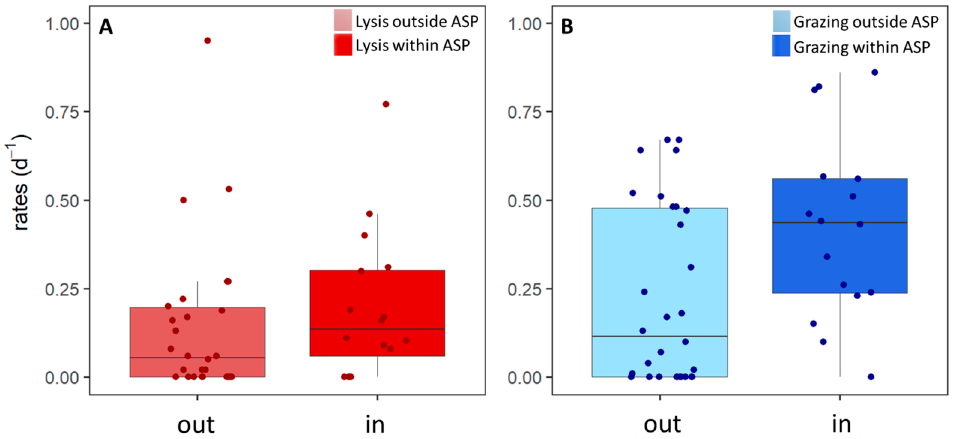
Figure 5. Viral lysis ( A ) and microzooplankton grazing ( B ) rates from stations outside and within the Amundsen Sea Polynya (ASP). The black line shows the median, the boxes show the interquar- tile range (IQR), and the whiskers show minimum and maximum values without outliers. Outliers are defined as outside 1.5 × IQR. The colored dots show the direct data points. n -numbers were 30 and 16 for outside and within the ASP, respectively.